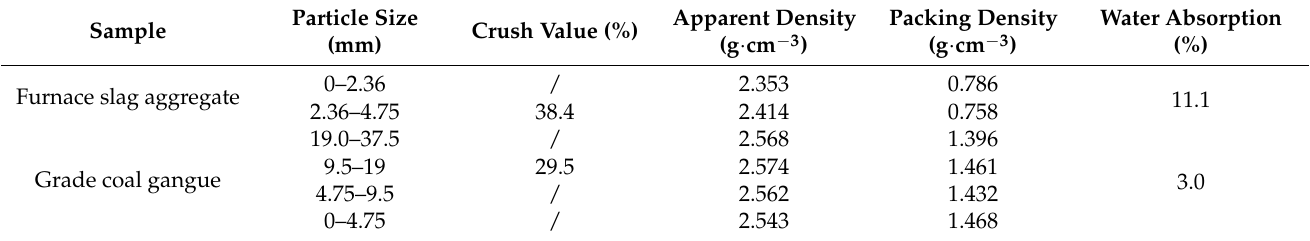
Table 2. Basic properties of the furnace slag and coal